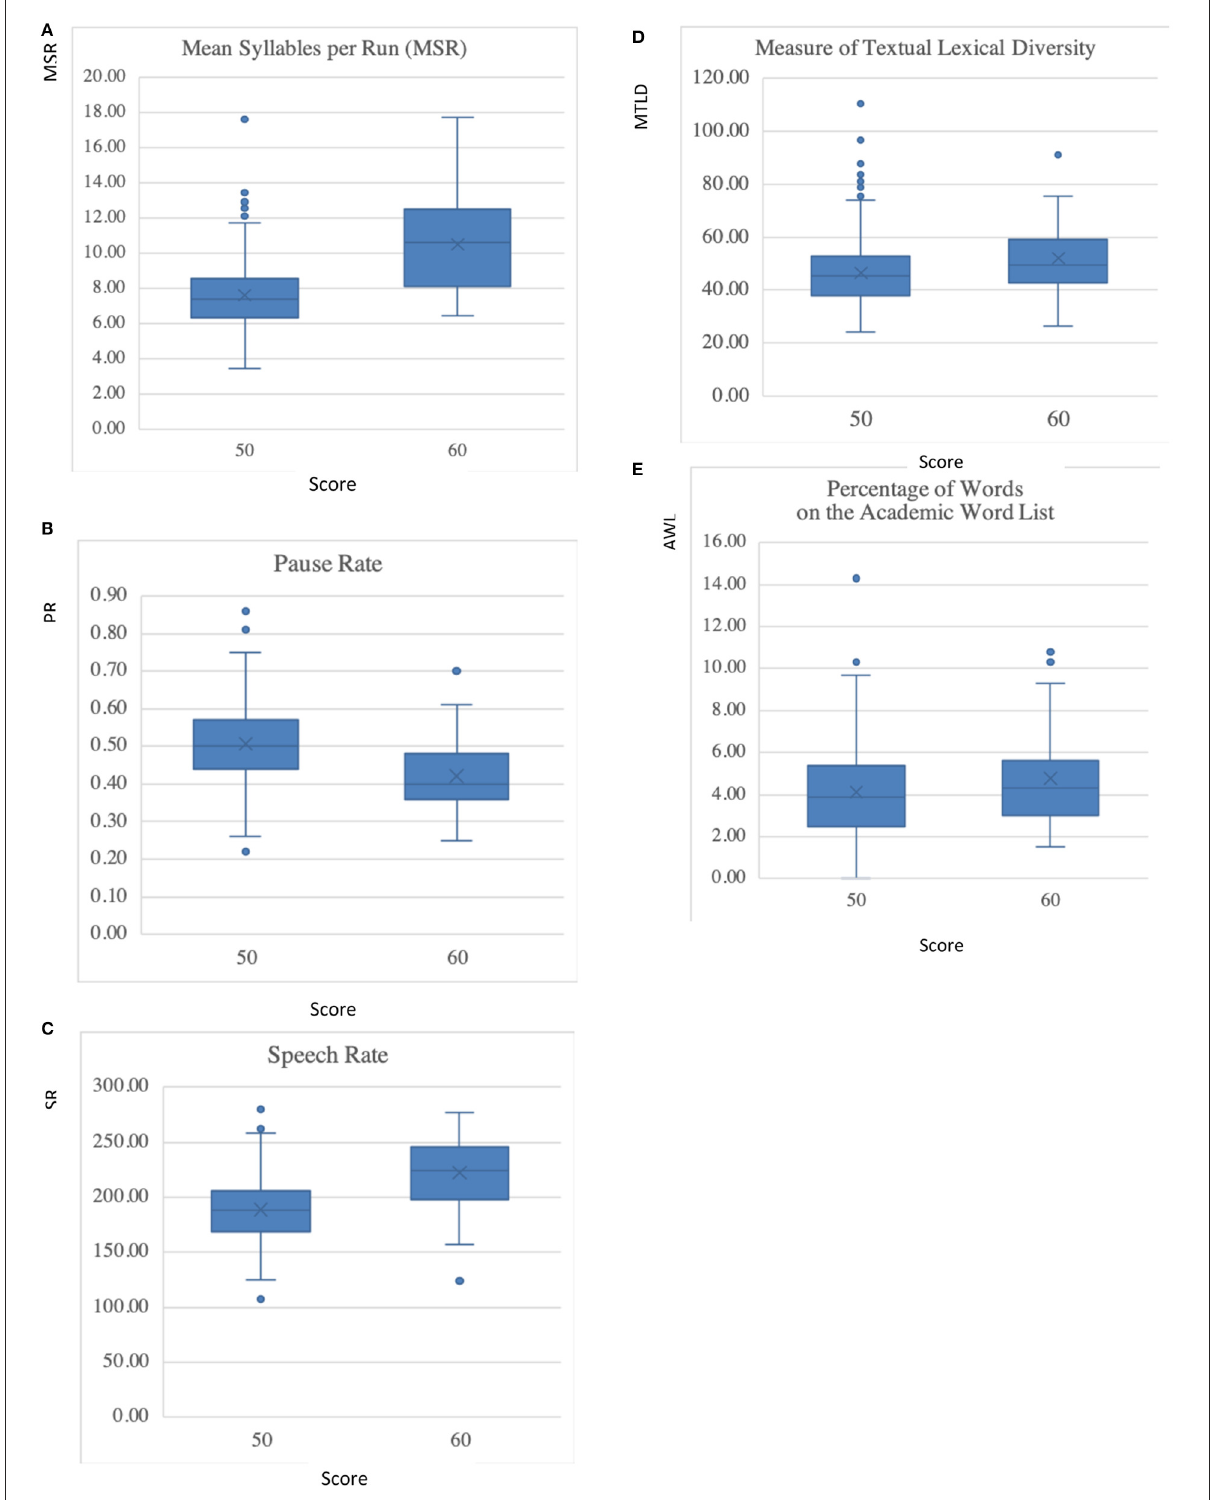
FIGURE2 Boxplots of fluency and vocabulary measures across proficiency levels. (A) Mean Syllables per Run (MSR). (B) Pause Rate. (C) Speech Rate. (D) Measure of Textual Lexical Diversity (MTLD). (E) Percentage of Words in the Academic Word